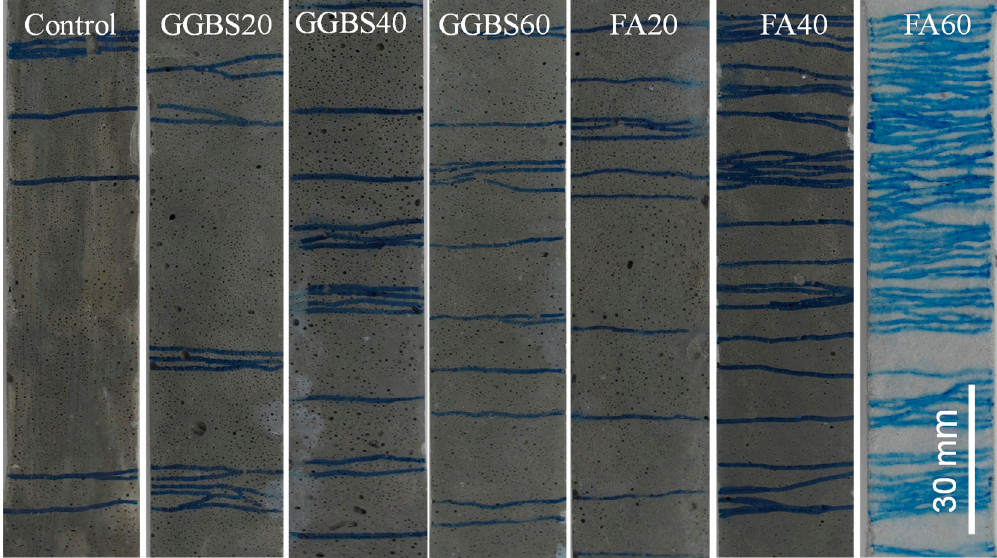
Figure 11. Typical crack patterns of ULHS-ECCs in the current study.